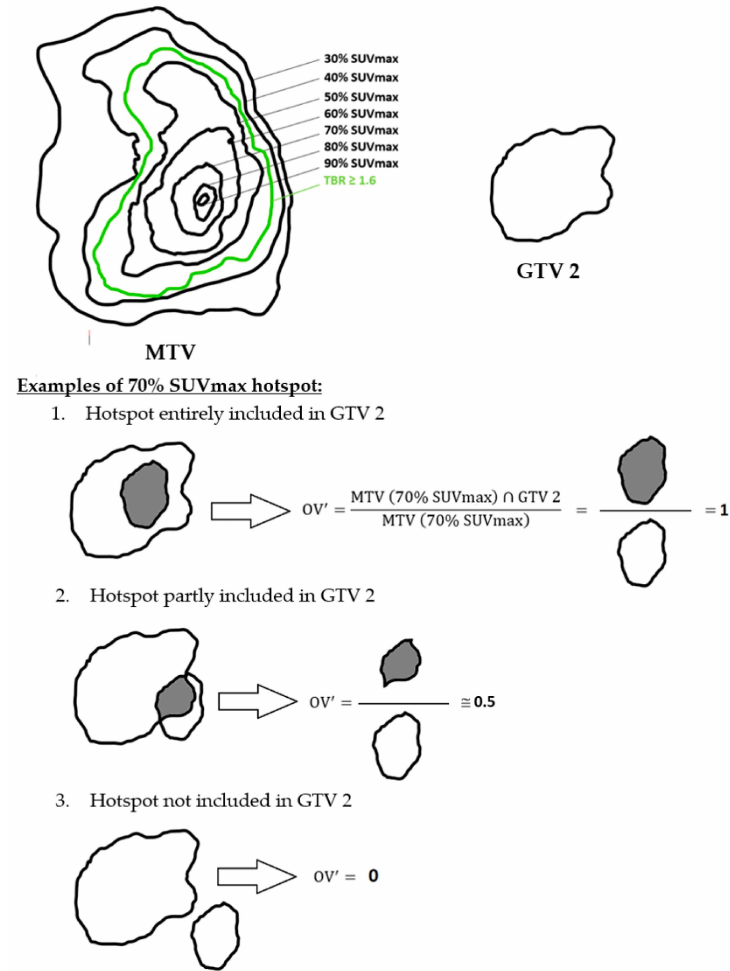
Figure 7. Simplified schematic representation of the hotspot concept using the 70% SUVmax threshold with GTV